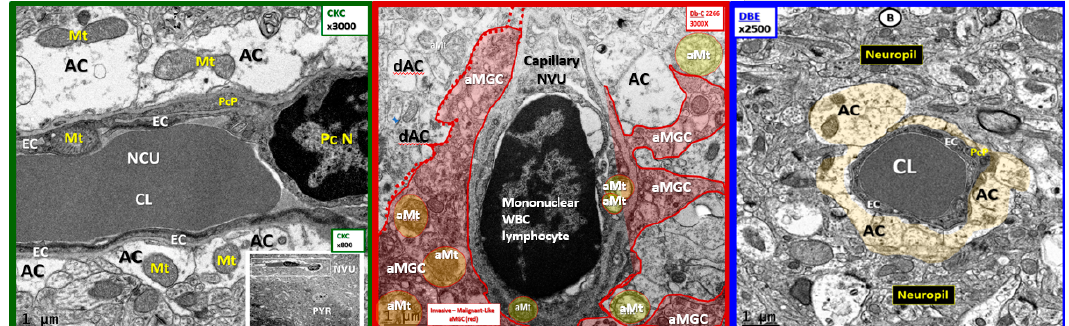
Figure 4. A comparison of the control, diabetic db / db , and empagliflozin-treated models: The control CKC (far left) depicts multiple tightly adherent intact astrocyte end-feet foot processes (ACfp) to the basement membrane (BM) of the capillary lumen (CL) of the neurovascular unit (NVU). Also note that the AC tightly adheres not only to the basement membranes of endothelial cells (EC) but also to the BM of the pericyte process (PcP) of the protective pericyte nucleus (PC N). Also note the very heavily elongated, electron-dense tight and adherence junctions at the endothelial cell (EC) paracellular cell–cell junctions where the ECs overlaps. The insert (lower right) demonstrates the proximity of the NVU to the regional pyramidal neuron (PYR). The middle panel demonstrates the near complete loss of ACs leaving only one intact AC that is partially detached, with the remainder ACs being detached separated and retracted (dAC). Note the activated microglial cell (aMGC pseudo-colored red) separating the ACs from the basement membrane of the NVU. The far-right panel illustrates that the treatment with empagliflozin protects the ACs from detachment, separation, and retraction and that the capillary NVU is completely encircled by a corona of six intact and tightly adherent ACs (pseudo-colored golden). The magnifications at the top of each panel, and the scale bars are at the bottom. Available via license CC BY 4.0.